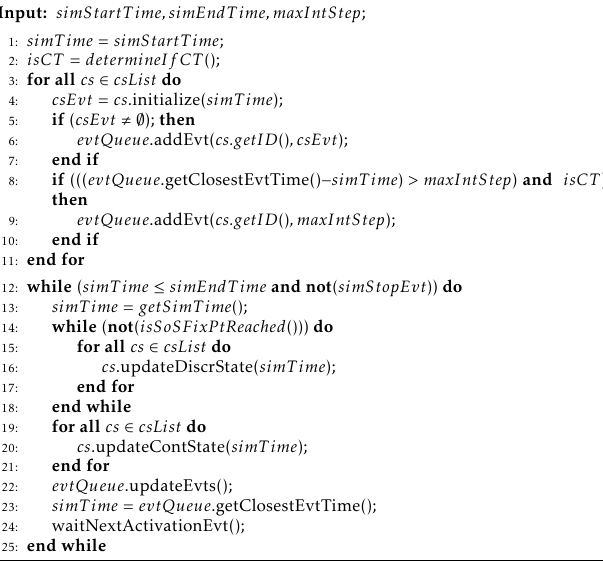
Algorithm 1 DESYRE FMI MA for